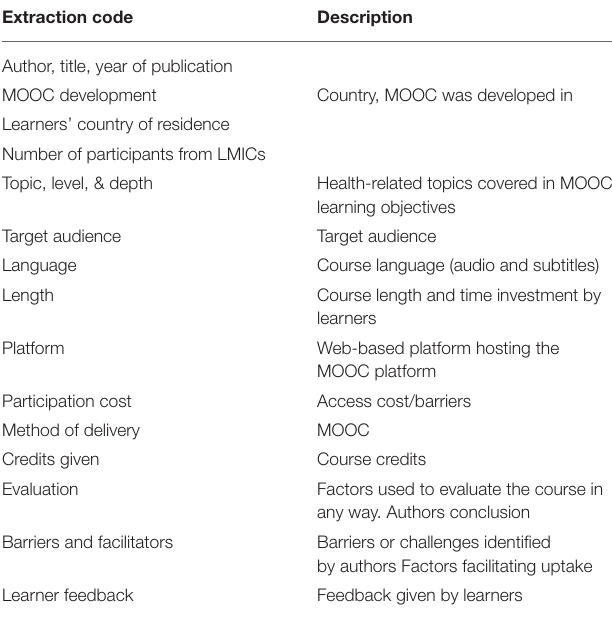
TABLE 3 | Full list of extraction criteria and their